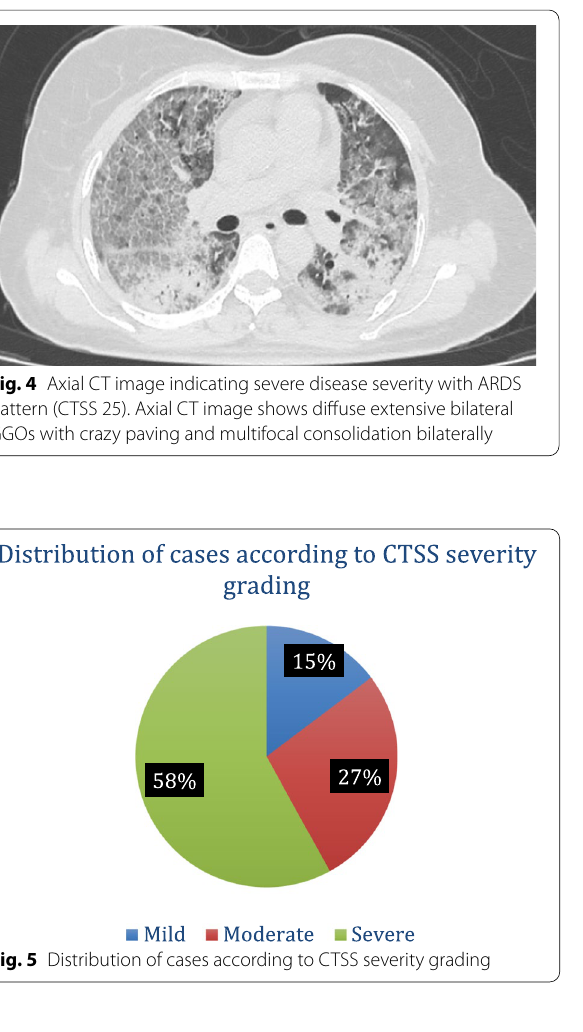
Table 2 Demographic and baseline characteristics of patients